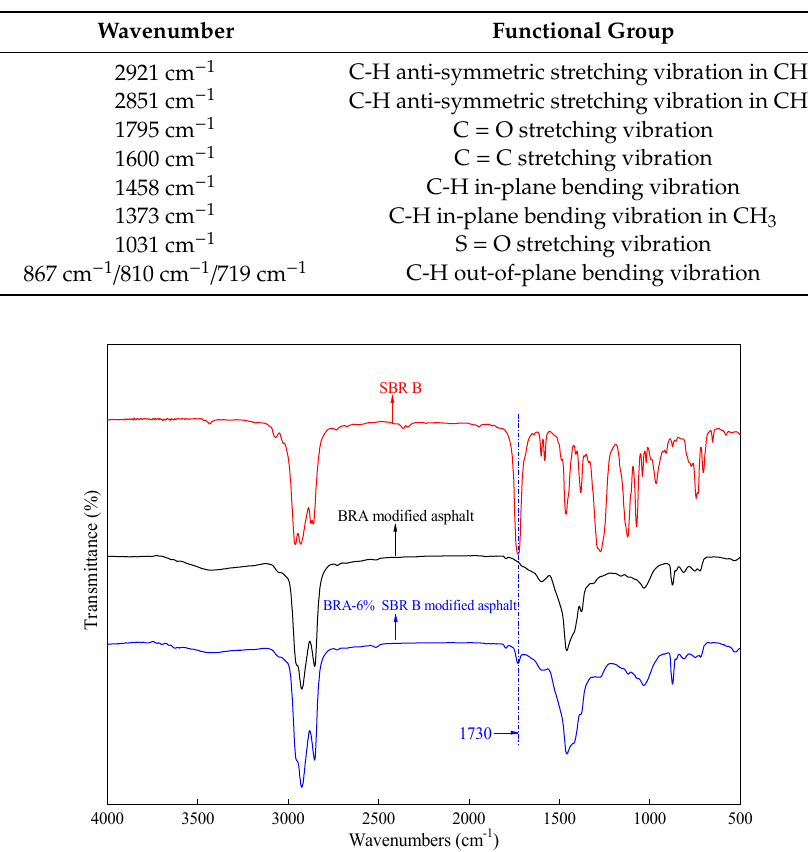
Figure 9. FTIR of BRA modified asphalt before and after modifying by 6%SBR B.